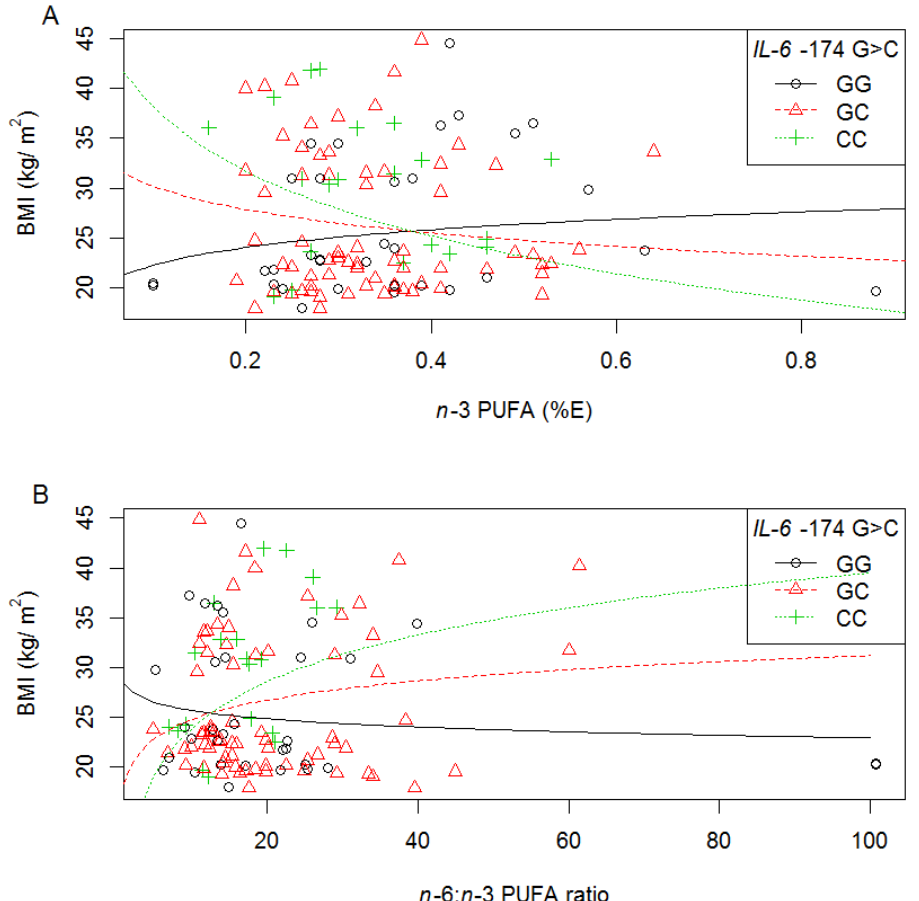
Figure 4. The relationship between BMI, IL-6 −174 G>C polymorphism and dietary fat intake in white women. Symbols represent, for each woman, observed values. The lines are modeled relationships for a woman of average age (27.3 years). ( A ) With increasing n -3 PUFA intake (%E), BMI decreased in those with the −174 CC or GC genotypes ( R 2 = 0.17, p = 0.027); ( B ) With increasing n -6: n -3 PUFA ratio, BMI increased equally with each additional −174 C allele ( R 2 = 0.8, p =